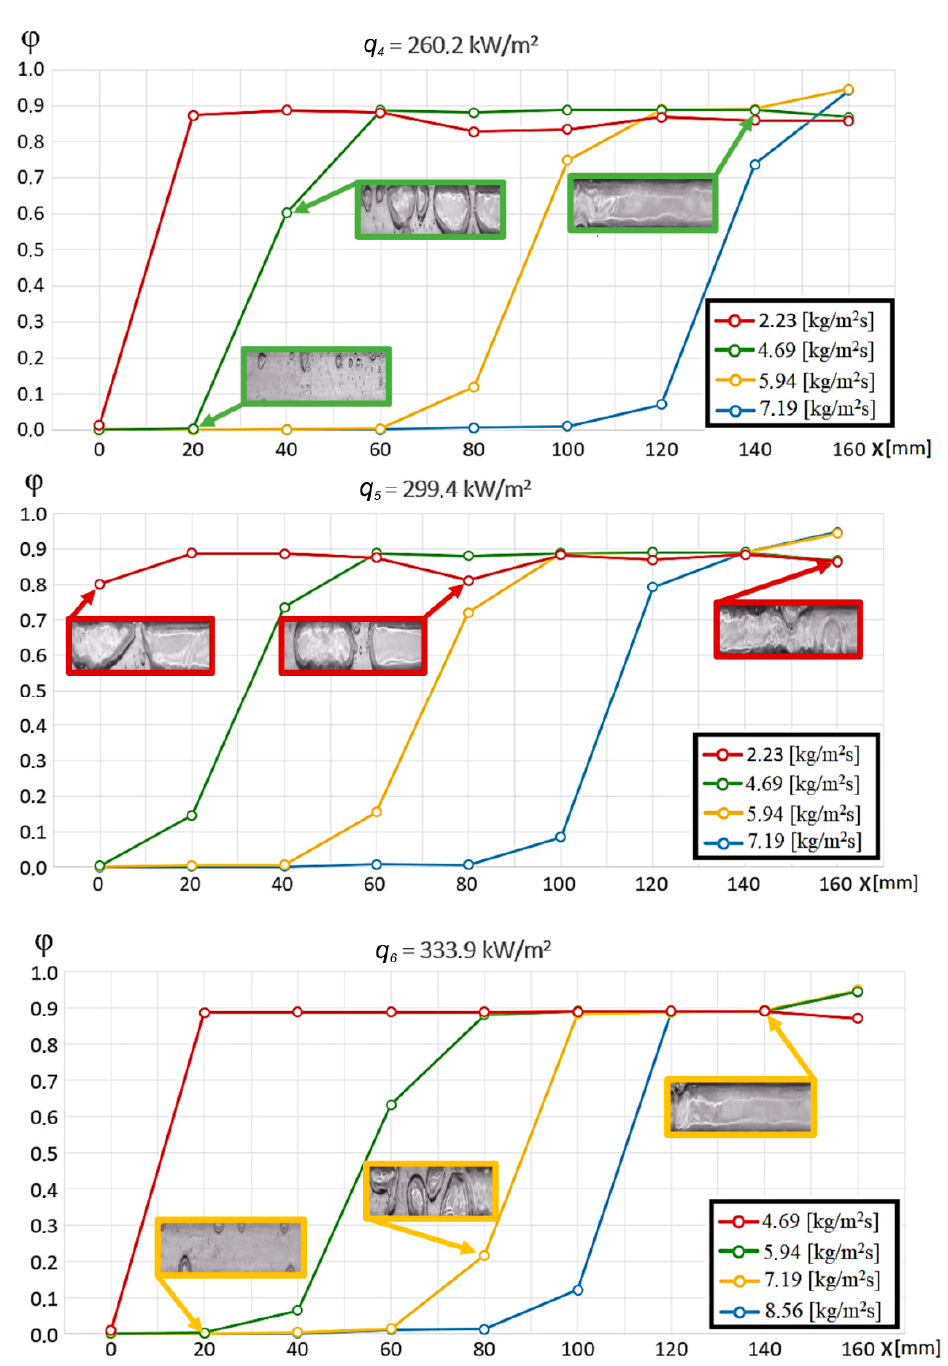
Figure 12. Dependence of the local void fraction for water on the distance from the entrance to the horizontal mini-channel for variable heat fluxes and mass fluxes , q 4 < q 5 < q 6 . The color of the frame around the photo of the two-phase flow structure represents the color of the corresponding polyline curve in the graph.